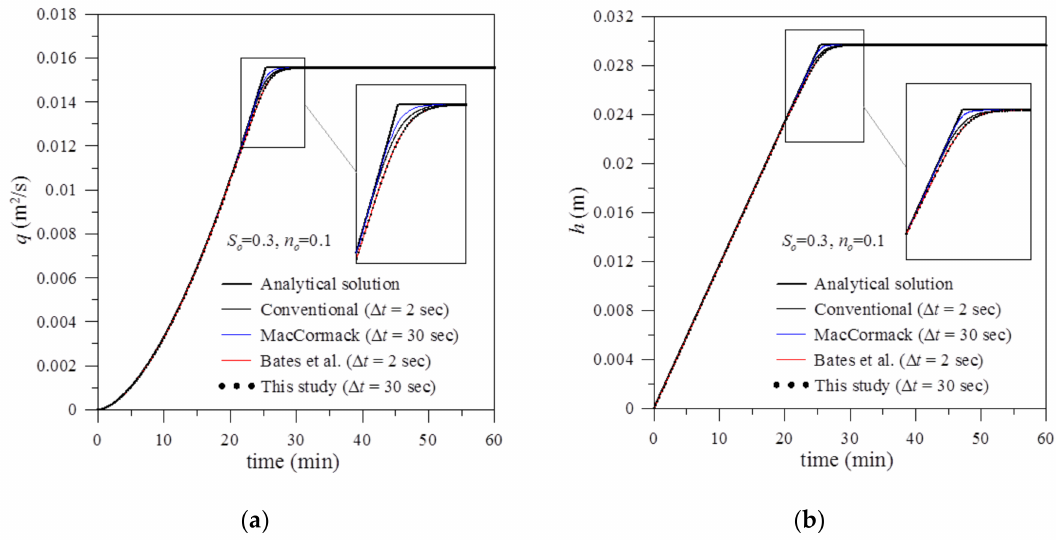
Figure 14. Predicted and analytical hydrographs using different algorithms, ( a ) Discharge, ( b ) Water